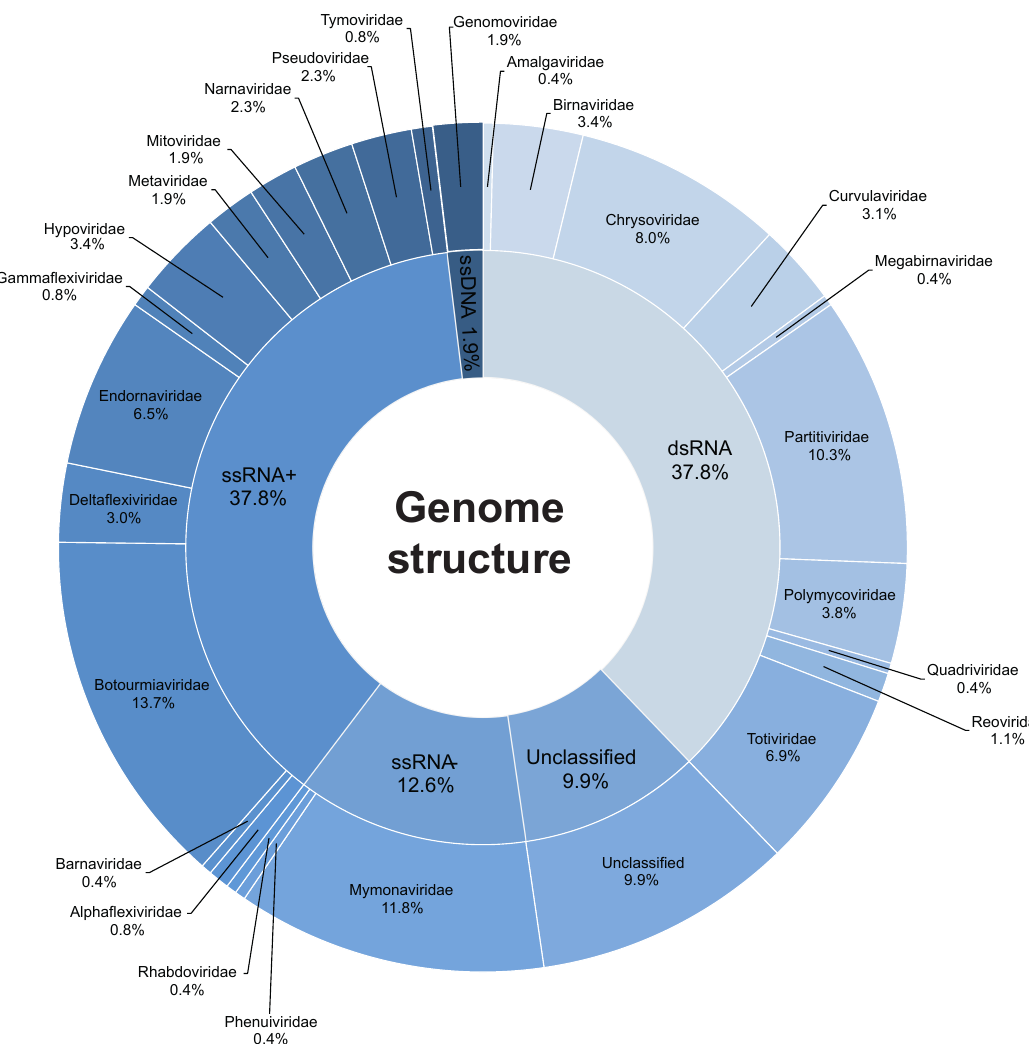
Figure 1. Genomic characteristics of mycovirus species classified by genomic structure. Fungal viruses were found infecting five different phyla from the Fungi